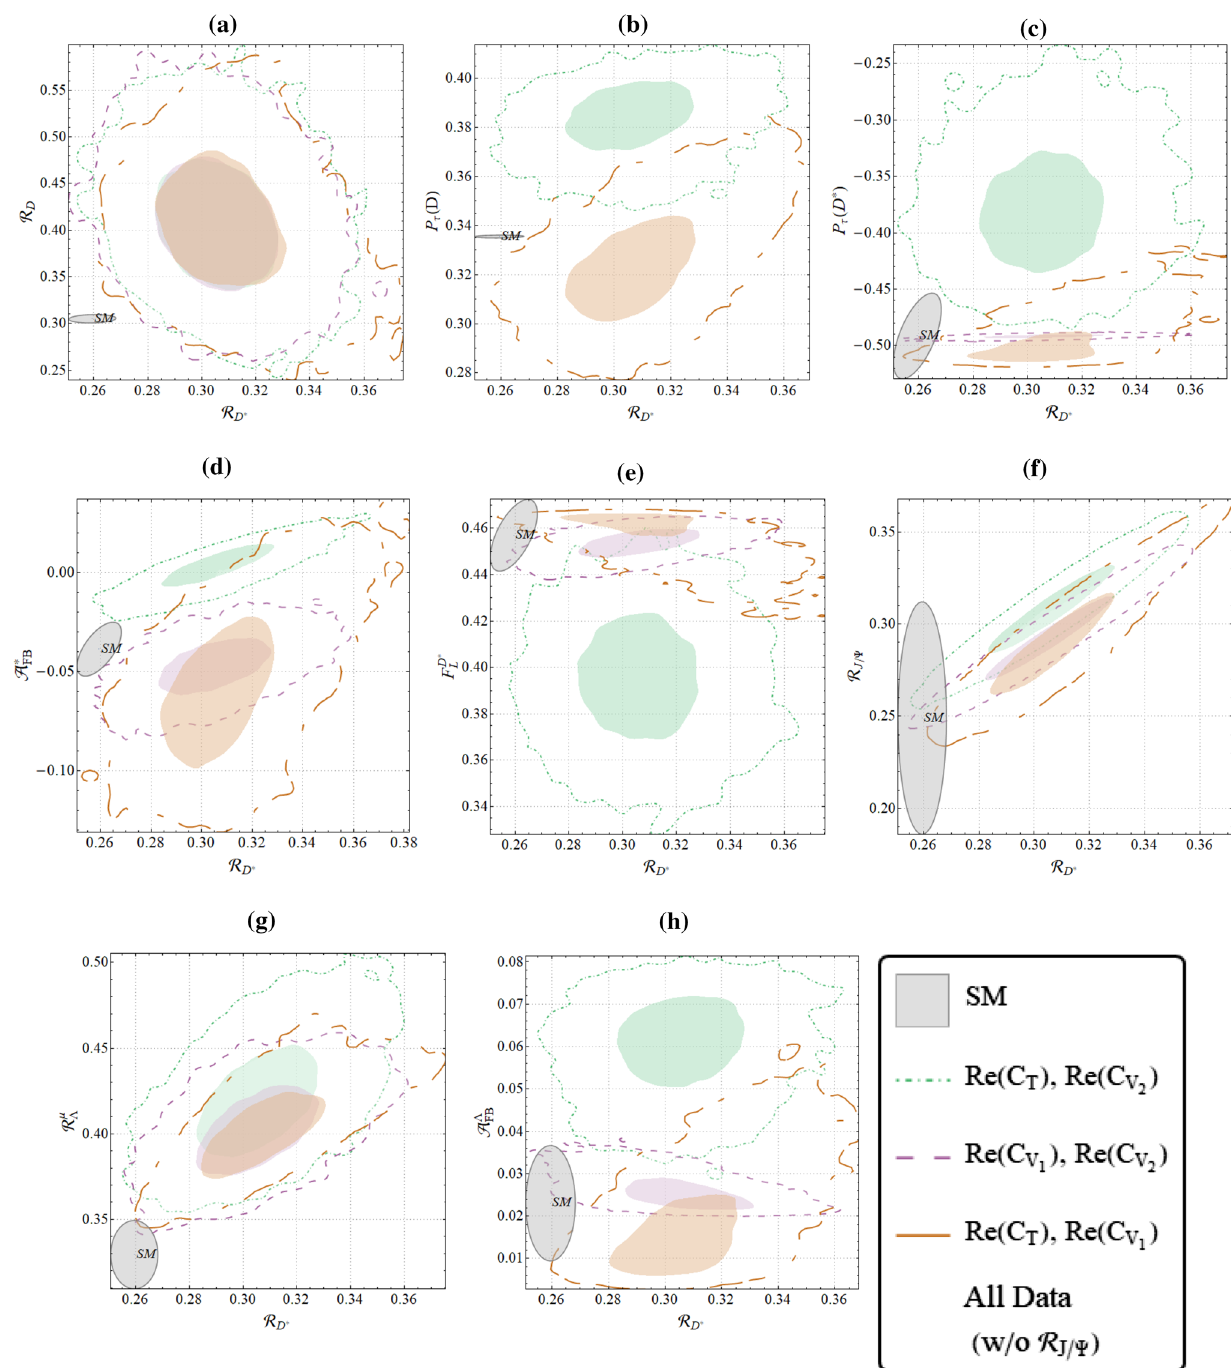
(cid:20) (cid:21) ), R e ( C ) R e ( C dashed)contourscorrespondtothescenarioswith , (cid:20) (cid:21) (cid:20) (cid:21) T V 2 ), R e ( C ) ), R e ( C ) R e ( C R e ( C and respectively. For each V 1 V 2 T V 1 of these scenarios, 1 σ (filled region) and 3 σ contours are